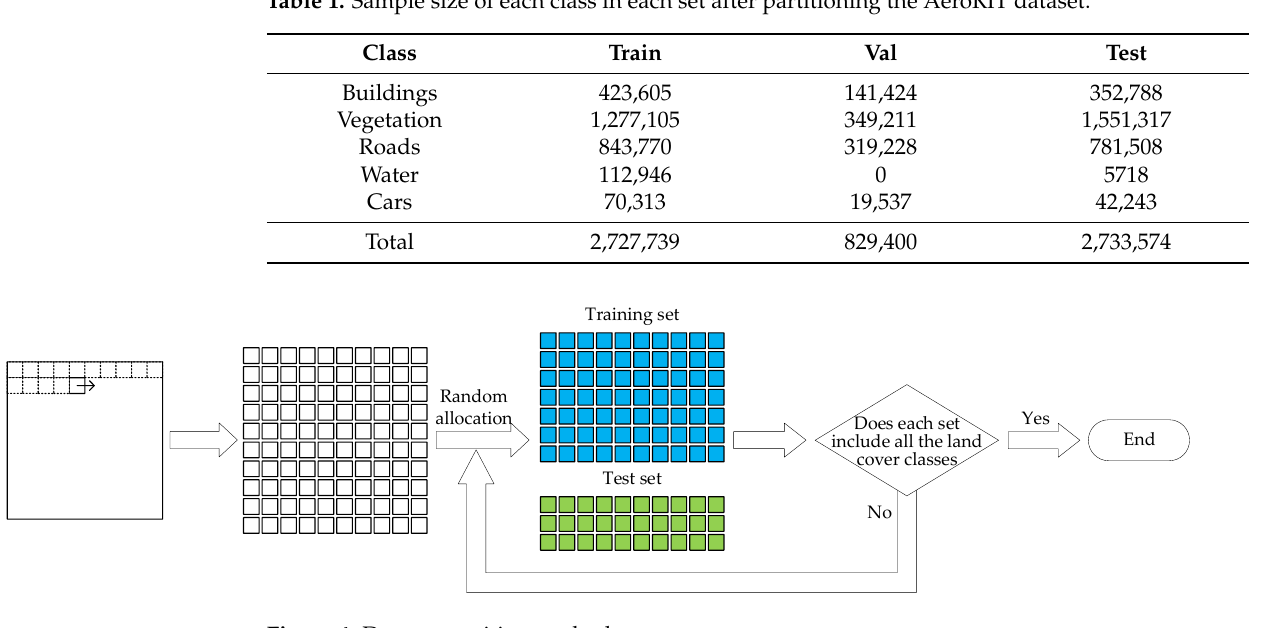
Table 1. Sample size of each class in each set after partitioning the AeroRIT dataset.